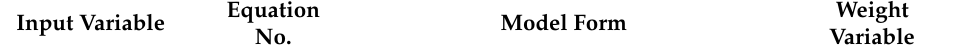
Weight Variable